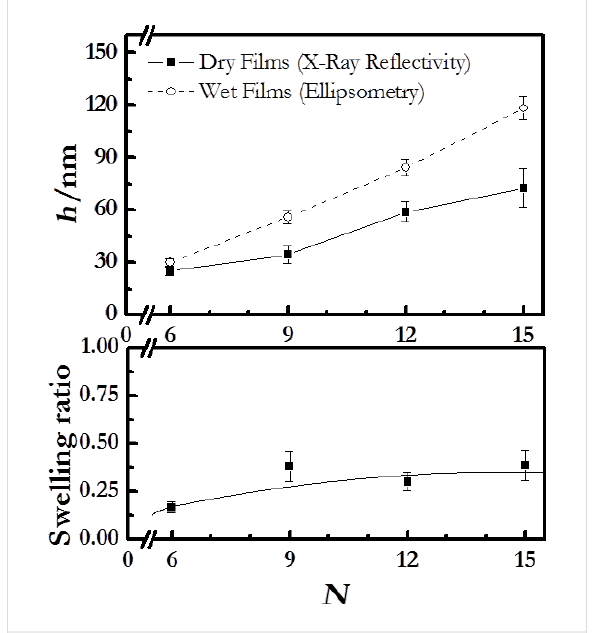
Figure 4: (a) Multilayer thickness of (PDADMAC + PSS) N films formed at an ionic strength of 0.10 M as a function of N , measured under wet conditions (ellipsometry) and dry conditions (X-ray reflectivity). (b) Swelling ratio as a function of N for the multilayers of part a. The lines are to guide the eye.